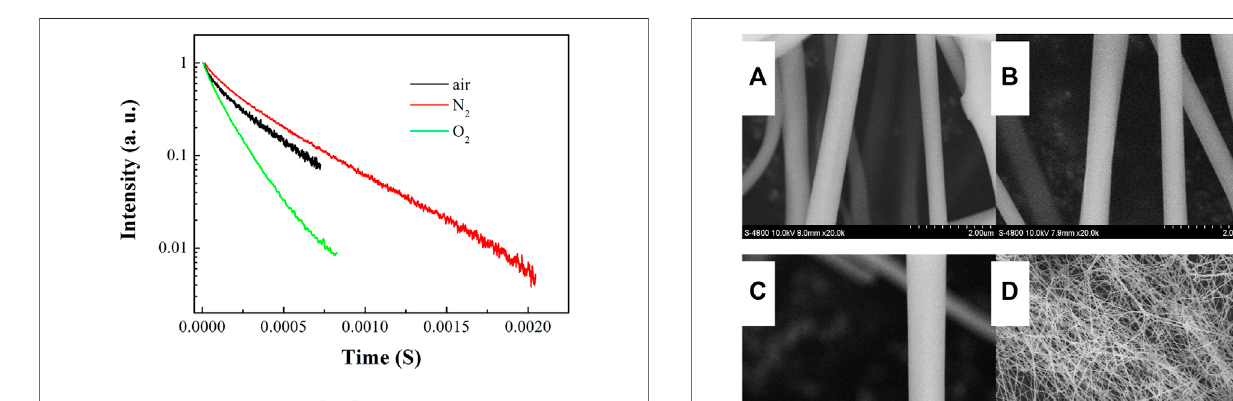
FIGURE 3 | Emission dynamics of 5 D 0 - 7 F 2 transition of Eu (N-DPNQ) (TTD) 3 upon air, pure N 2 and pure O 2 conditions.